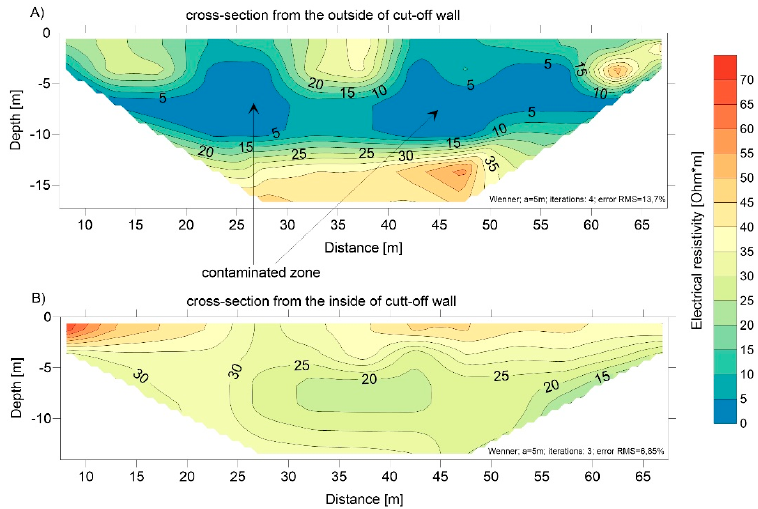
Figure 7. The electrical resistivity cross-section inside ( A ) and outside ( B ) the cut-off wall